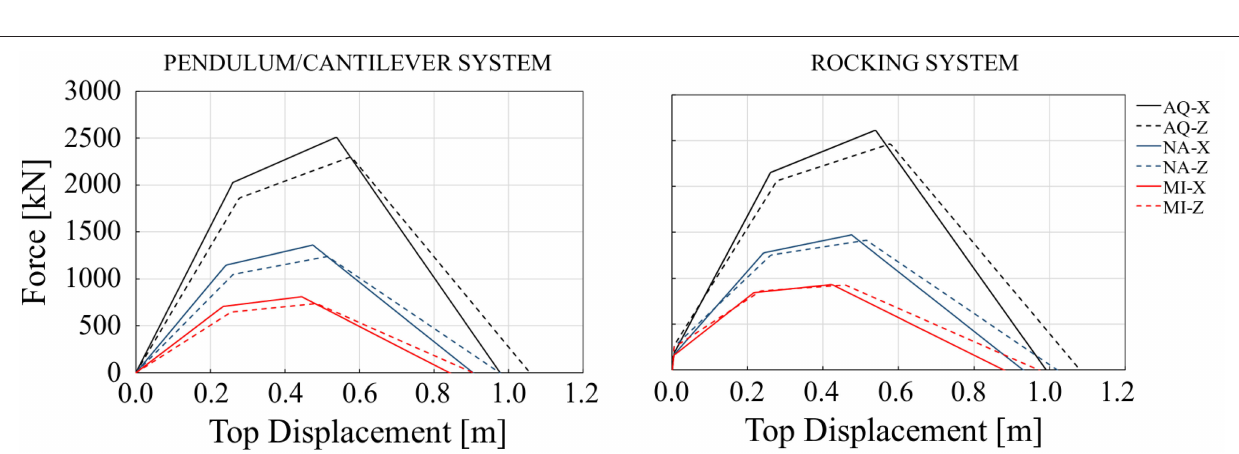
Frontiers in Built Environment |